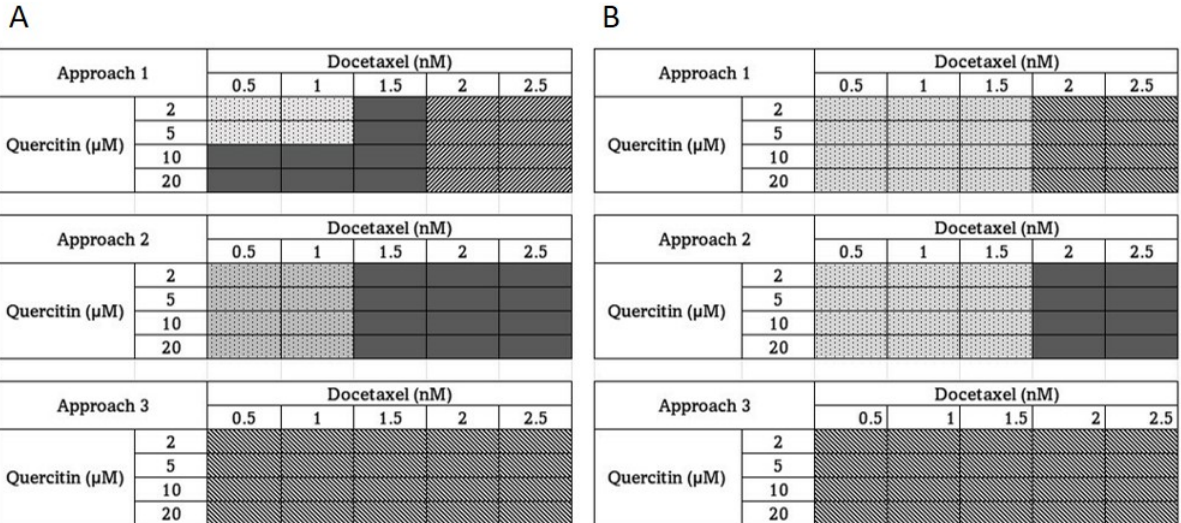
Figure 2. Combination cytotoxic effect of quercetin and docetaxel: ( A ) DU-145 (moderately aggres- sive), and ( B ) PC-3 (very aggressive human prostate cancer cells). Varying Que-Doc combinations were employed to treat the cells in accordance with three different treatment modalities: TAP:1 refers to simultaneous administration of both drugs for 24 h; TAP:2 to pre-treatment with Que for 24 h, then 24 h of treatment with Doc alone; and TAP:3 to pre-treatment with Doc for 24 h, then 24 h of simultaneous administration of both drugs. Cell viability (MTT assay) was assessed following the treatments and the combination index was calculated (CI). The CI values are presented as heat maps, with CI values < 0.9 (filled with dotted square) denoting a synergistic effect, CI values 0.9 ≤ CI ≤ 1.1 (filled with grey squares) denoting an additive effect, and CI value > 1.1 (filled with hatched squares) denoting an antagonistic effect.